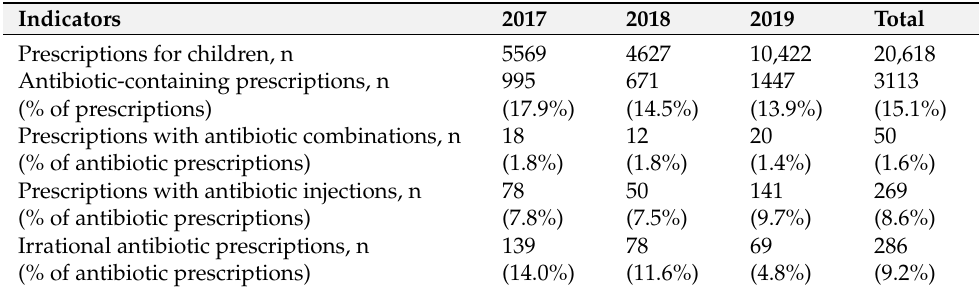
Table 1. Selected indicators of prescriptions for children from all PHIs covered by Beijing Prescription Reviewing System of Community Healthcare institutions,